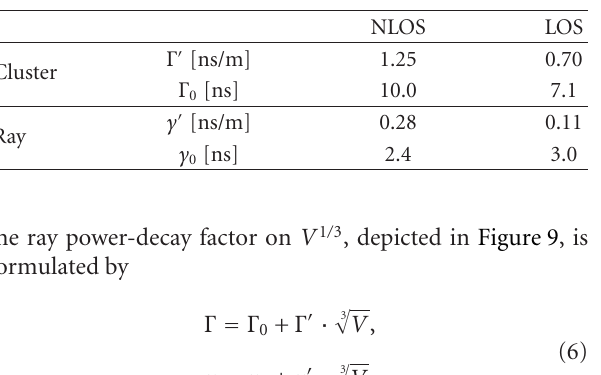
Table 3: The parameter of decay factor functions for the cluster and the ray within the